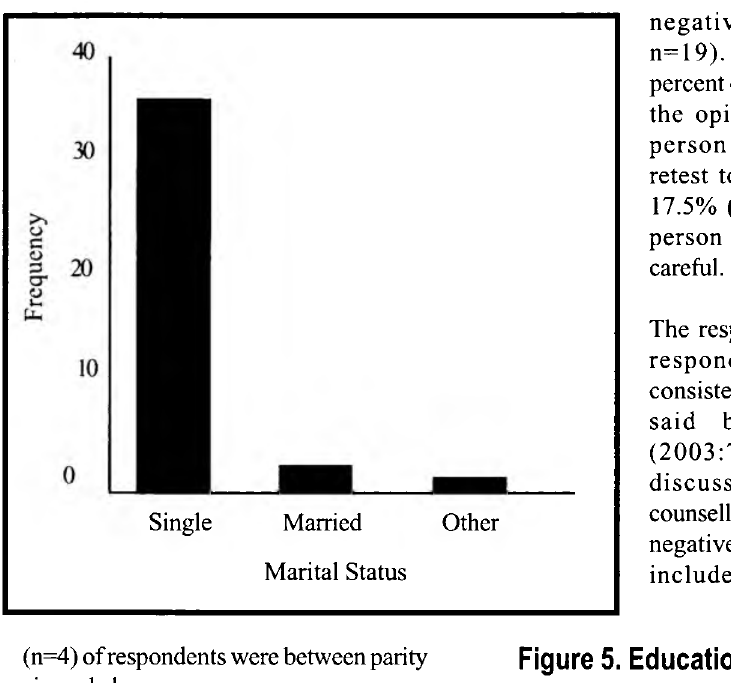
Figure 5. Educational standard